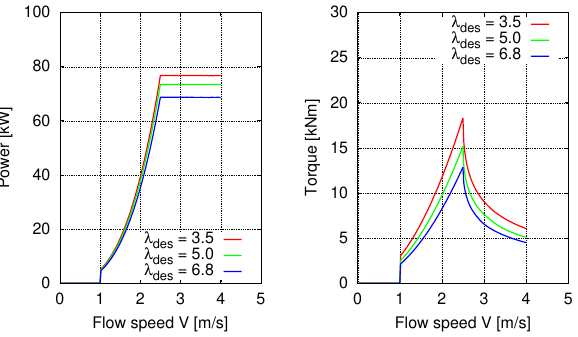
Fig. 27. Full-scale turbine, V des = 2 . 5 m/s: power (left) and torque (right) curves as function of flow speed.